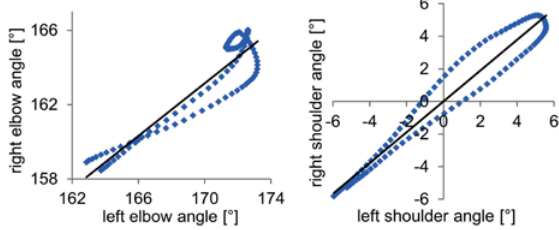
Figure 7. Example of the elbow-elbow and shoulder-shoulder cyclogram with the principal